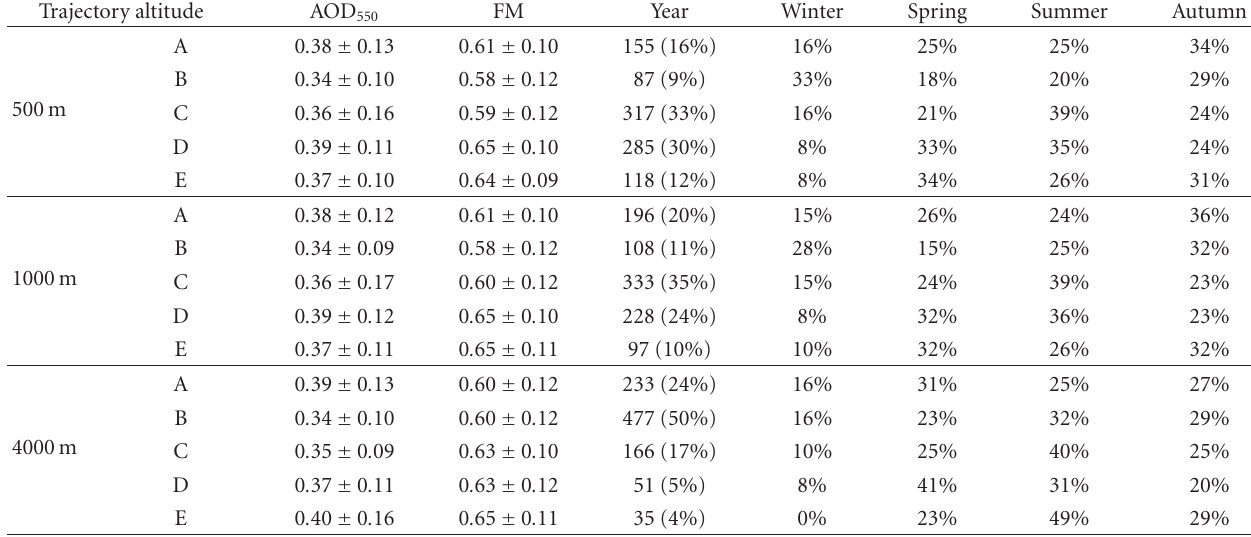
Table 1: Mean values of AOD 550 and FM fraction for all aerosol types over GAA. These values correspond to the whole dataset. The number and the relative frequency of the trajectories from each sector are also given for the three altitude levels: 500 m, 1000 m, and 4000 m.